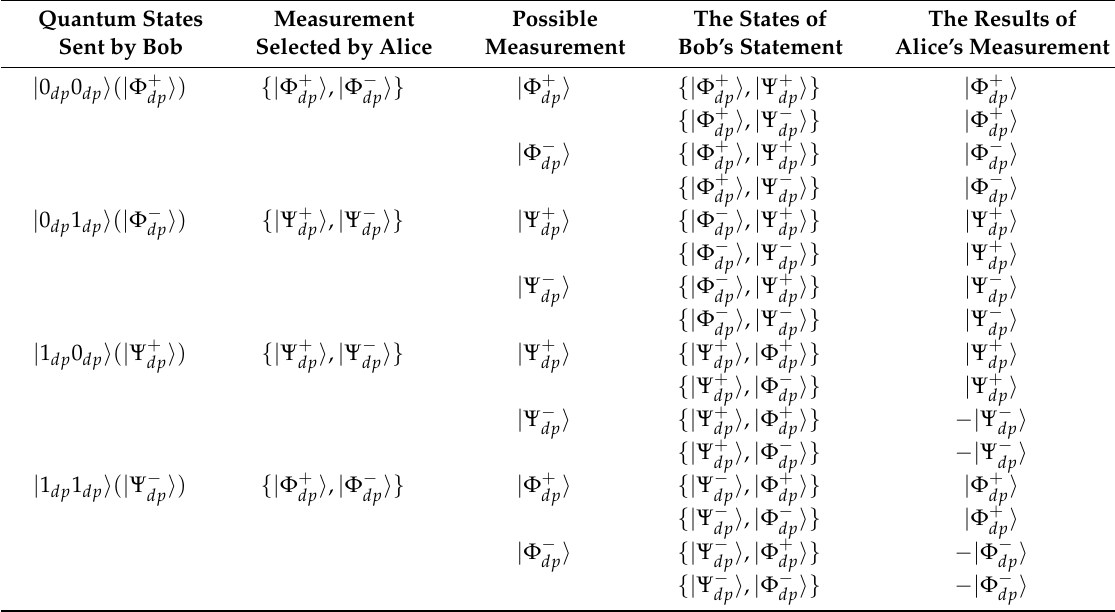
Table 2. Deterministic